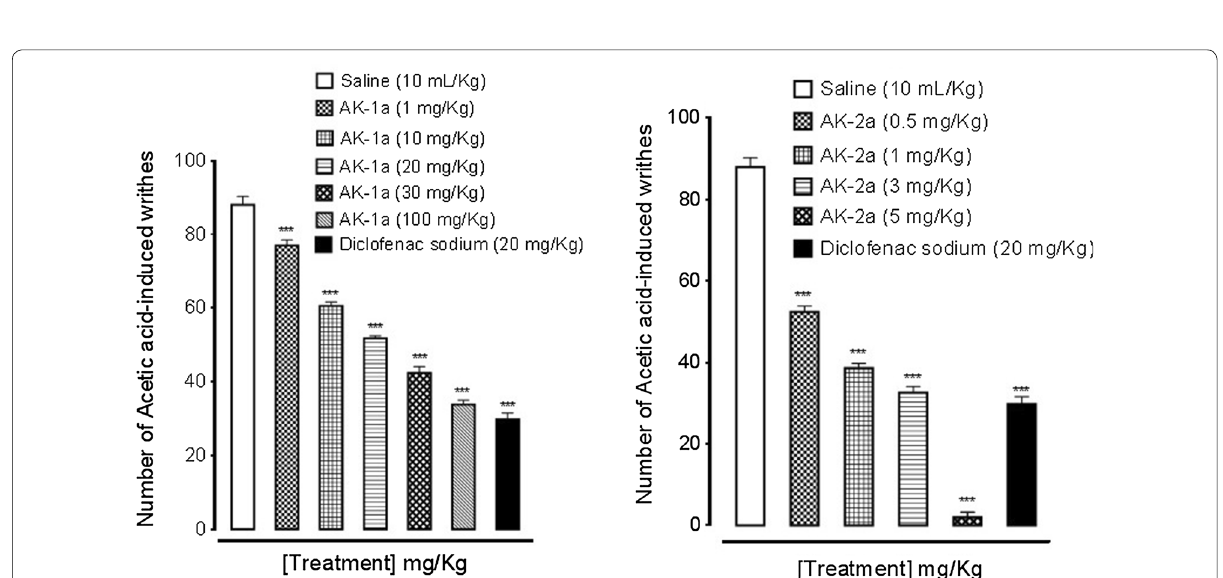
Fig. 13 Effect of (2 E ,5 E )‑2‑(4‑methoxybenzylidene)‑5‑(4‑nitrobenzylidene) cyclopentanone (AK‑1a), (1 E ,4 E )‑4‑(4‑nitrobenzylidene)‑1‑(4‑nitrophenyl) oct‑1‑en‑3‑one (AK‑2a) and diclofenac sodium on acetic acid‑induced writhes in mice. Data expressed as mean group, one way ANOVA with post hoc Tukey’s